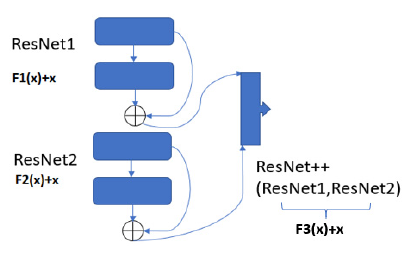
Figure 7. Schematic representation of the hybrid V-Net architecture. The encoder phase consists of two fusion blocks while the decoder phase consists of the ET-Net architecture and the output layer ResNet ++ blocks.